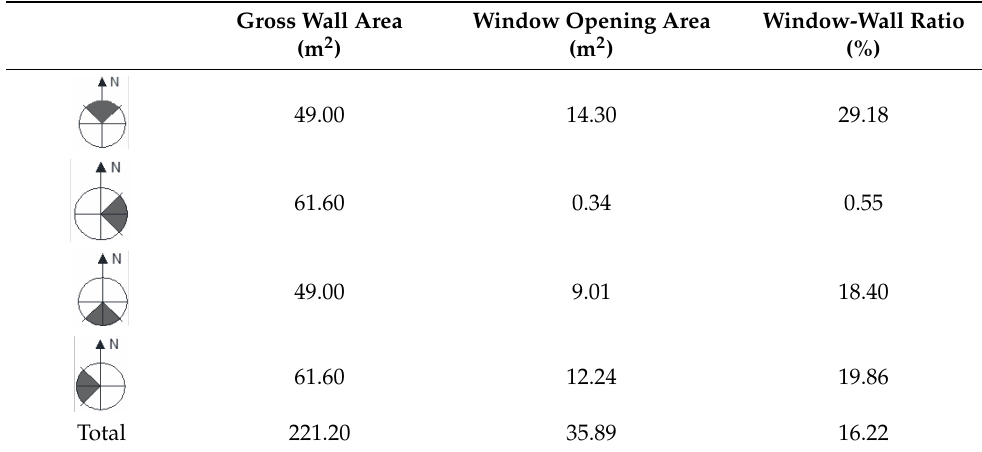
Table 1. Glazing surfaces and window-to-wall ratio of the case